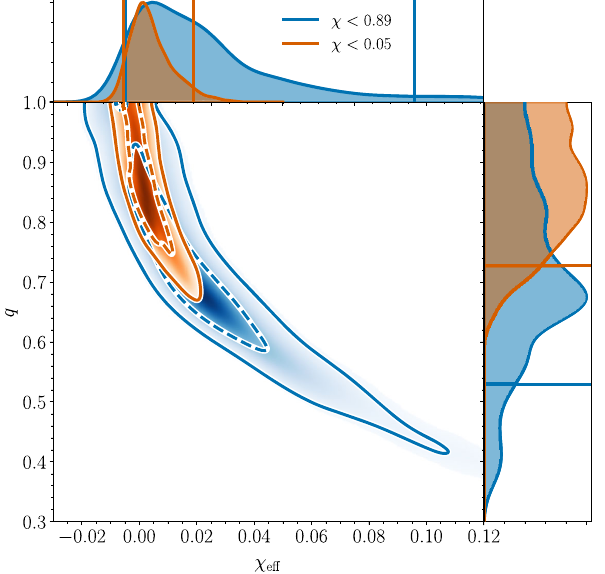
FIG. 7. Marginalized two-dimensional posteriors for the effec- tive spin χ and mass ratio q using the PhenomPNRT model for eff the high-spin prior (blue) and low-spin prior (orange). The 50% (dashed line) and 90% (solid line) credible regions are shown for the joint posterior. The 90% credible interval for χ is shown by eff vertical lines, and the 90% lower limit for q is shown by horizontal lines. The 1D marginal distributions have been renormalized to have equal maxima.